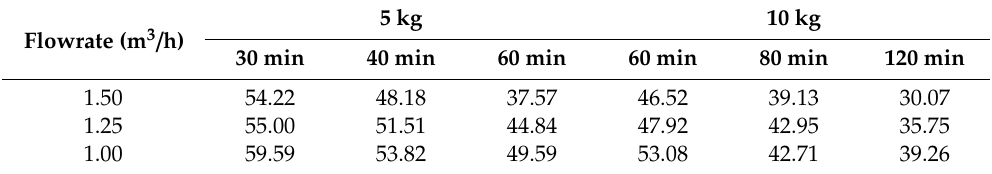
Table 2. Fertilizationconcentrationdeviation(%)ofthedesigneddeviceunderdifferentworkingparameters. Flowrate (m 3 /